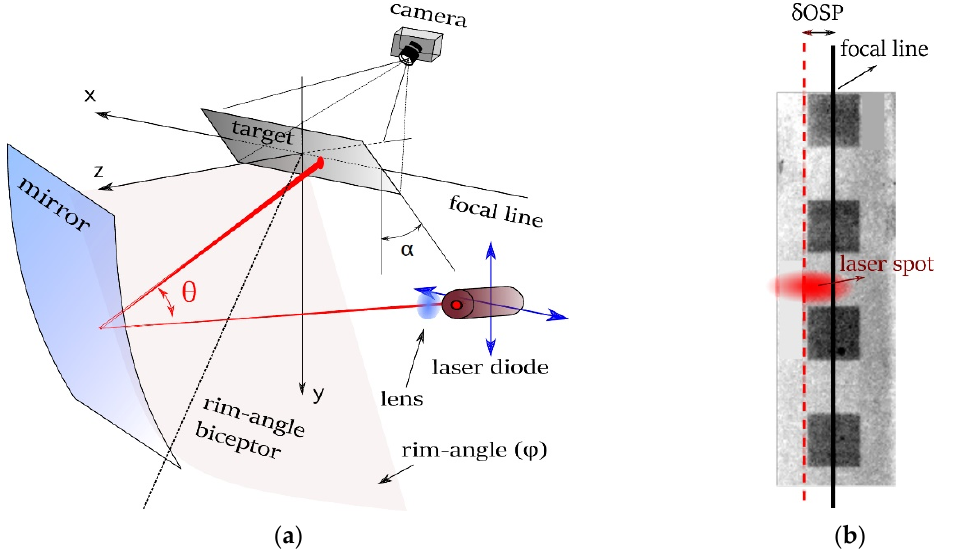
Figure 4. ( a ) Sketch of the experimental setup of laser profilometry on a m-PTC. The rim angle is in the light red color. ( b ) Picture of the target with the definition of the OSP displacement ( δ OSP). The laser beam is generated by a laser diode that can translate onto a plane parallel to the mirror aperture. The laser diode is a class IIIb laser of LASIRISTM, with a wave- length of 660 nm and an output power of 35 mW. Translation is provided by two auto- mated stages with an accuracy of 2 μ m and a range of 150 mm. The laser diode is inte- grated with a converging lens in front of it. The diameter of the laser spot is about 700 μ m in the best focus of the lens, where it has a circular shape.